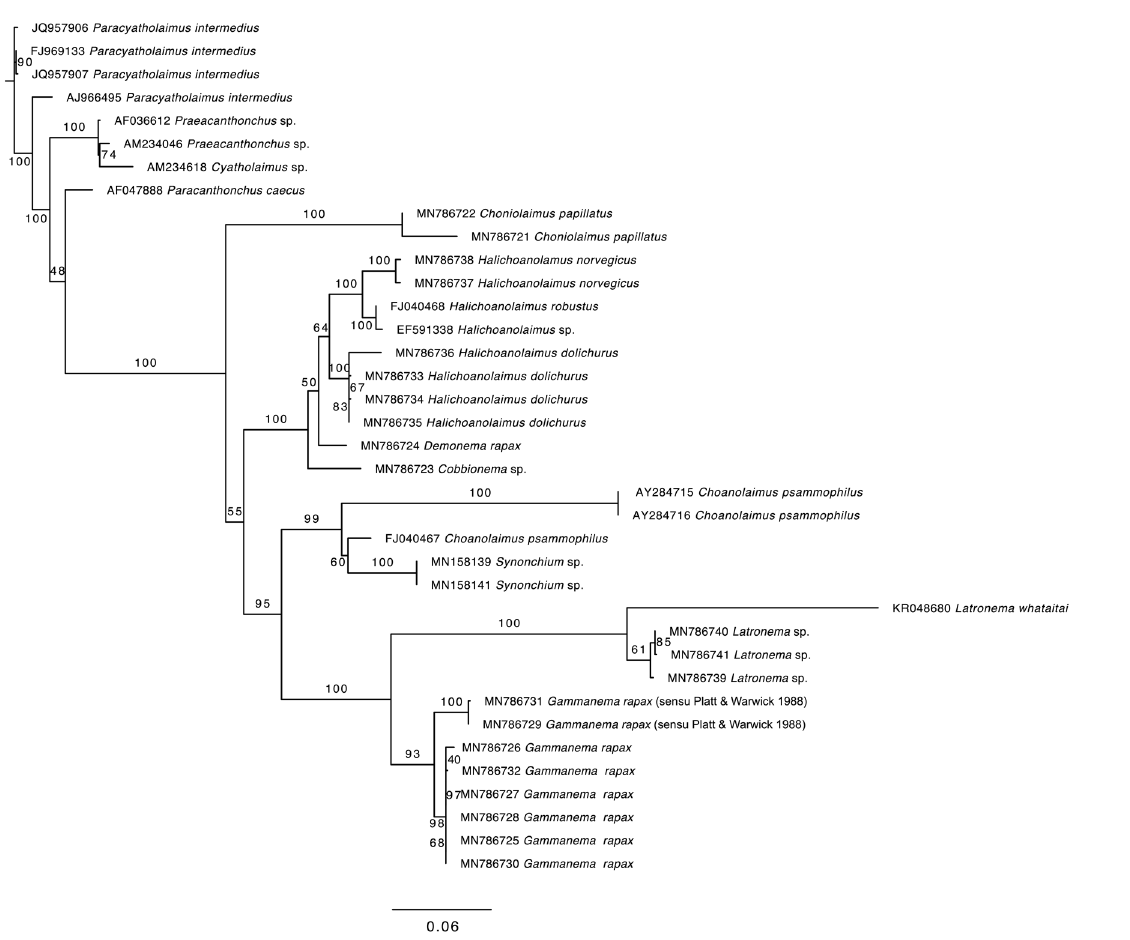
Fig. 10. Maximum Likelihood phylogenetic tree of Selachinematidae Cobb, 1915 inferred from 18S rRNA data, using alignments based on secondary structure models using GTR GAMMA for unpaired sites and RNA7A for paired